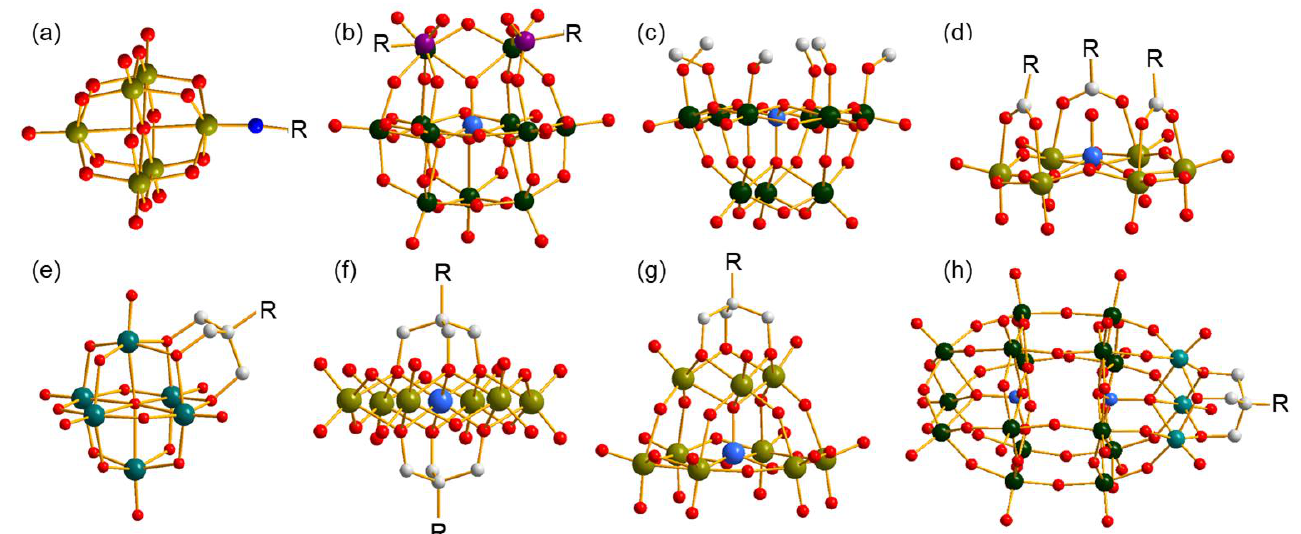
Figure 1. Ball-and-stick representation of several classical organo-functionalized clusters. ( a ) Imido- functionalized Lindqvist-type polyanion, ( b ) organophosphorus-functionalized lacunary Keggin-type polyanion, ( c ) methanol-functionalized lacunary Keggin-type polyanion, ( d ) carboxyl-functionalized Anderson-like-type polyanion; triol-ligand-functionalized ( e ) Lindqvist-type, ( f ) Anderson-type, ( g ) lacunary Keggin-type, and ( h ) Dawson-type polyanions. All H atoms are omitted for clarity. R represents the functional group. Dark cyan ball: V, olive ball: Mo, dark green ball: W, purple ball: P, light grey ball: C, red ball: O, blue ball: N, light blue ball: heteroatom.